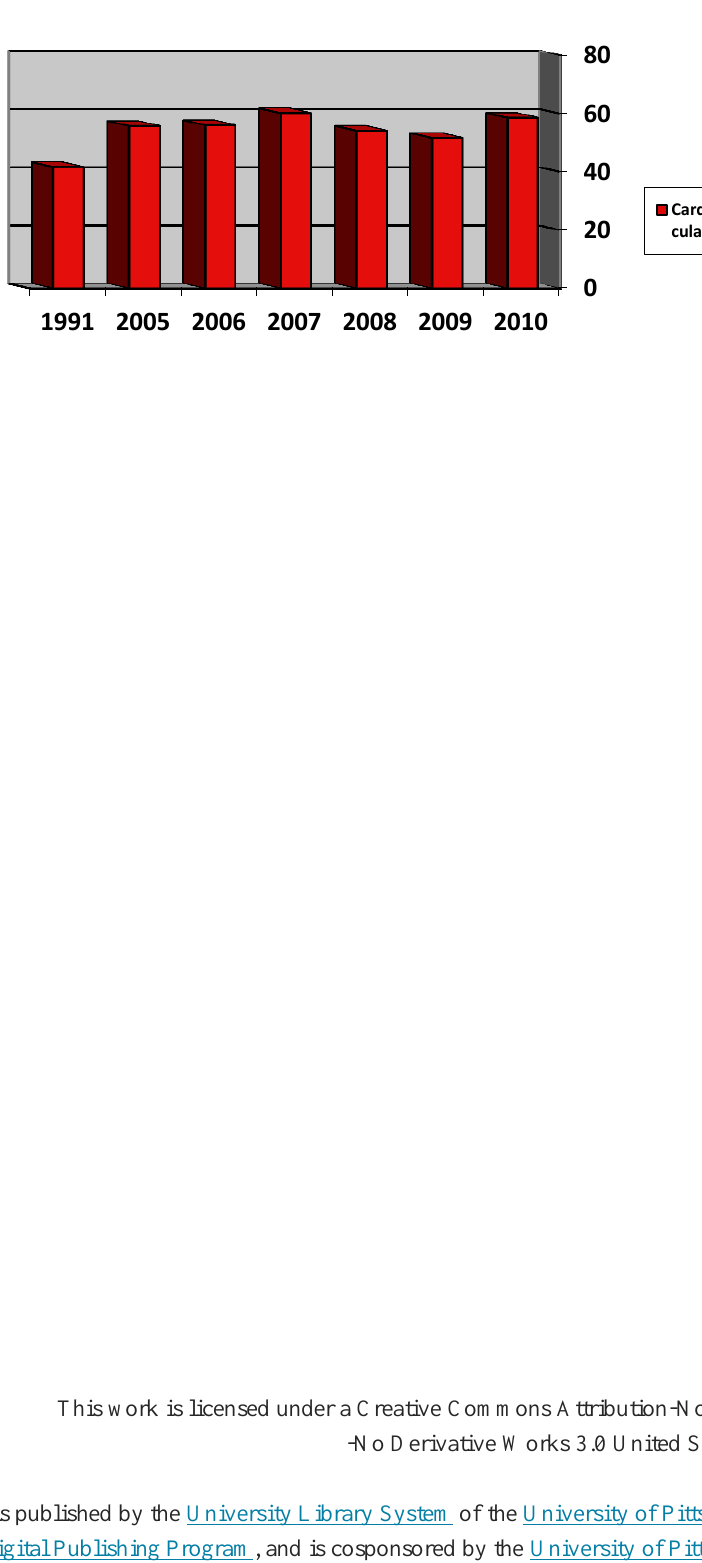
Figure 5: Death rate from cardiovascular diseases in Kyrgyzstan, ages